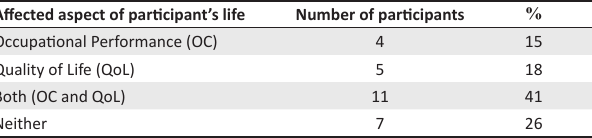
TABLE 5: The overall rating obtained by participants on the interview with regards to effects on occupational performance and quality of life: ( N =